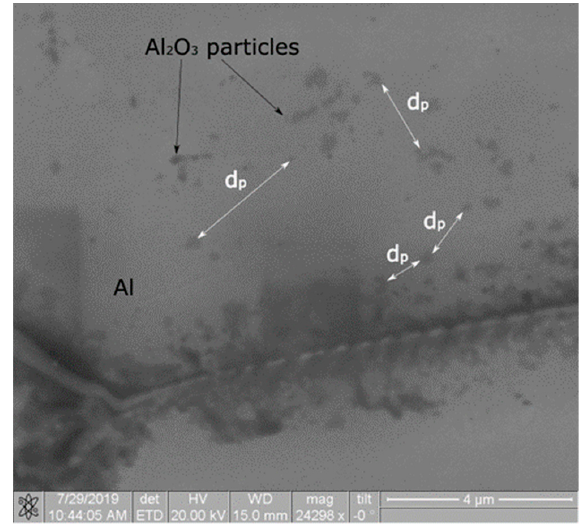
Figure 6. SEM image of the alloy sample with 1 wt.% Al 2 O 3 .